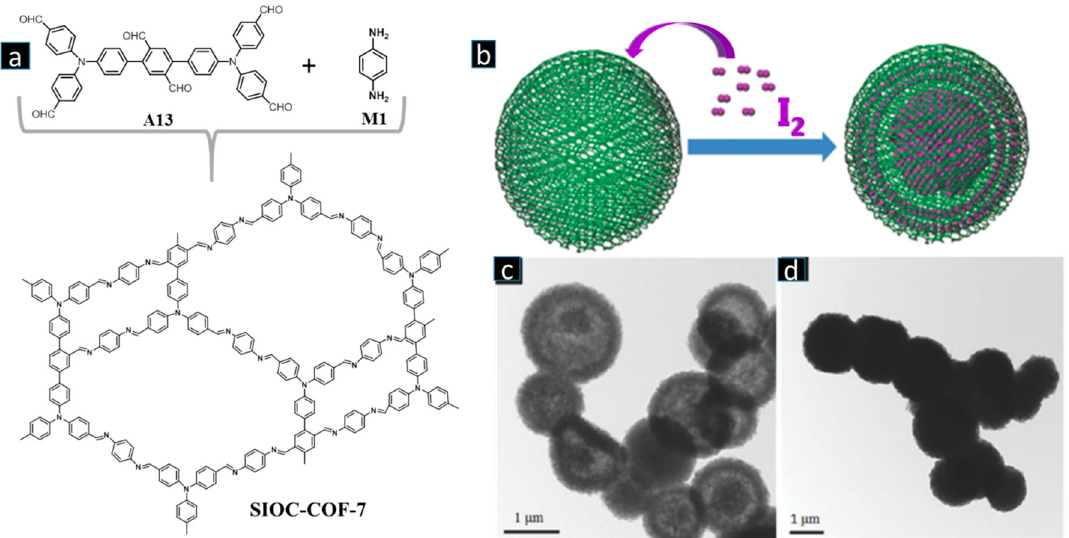
Figure 10. ( a ) Synthesis and structure of the heteropore COF SIOC-COF-7. ( b ) Cartoon illustration of iodine capture in the spherical COF. TEM images of SIOC-COF-7 ( c ) before and ( d ) after the COF was exposed to iodine vapor. Reprinted/adapted with permission from Ref. [47]. Copyright (2017), Royal Society of Chemistry.